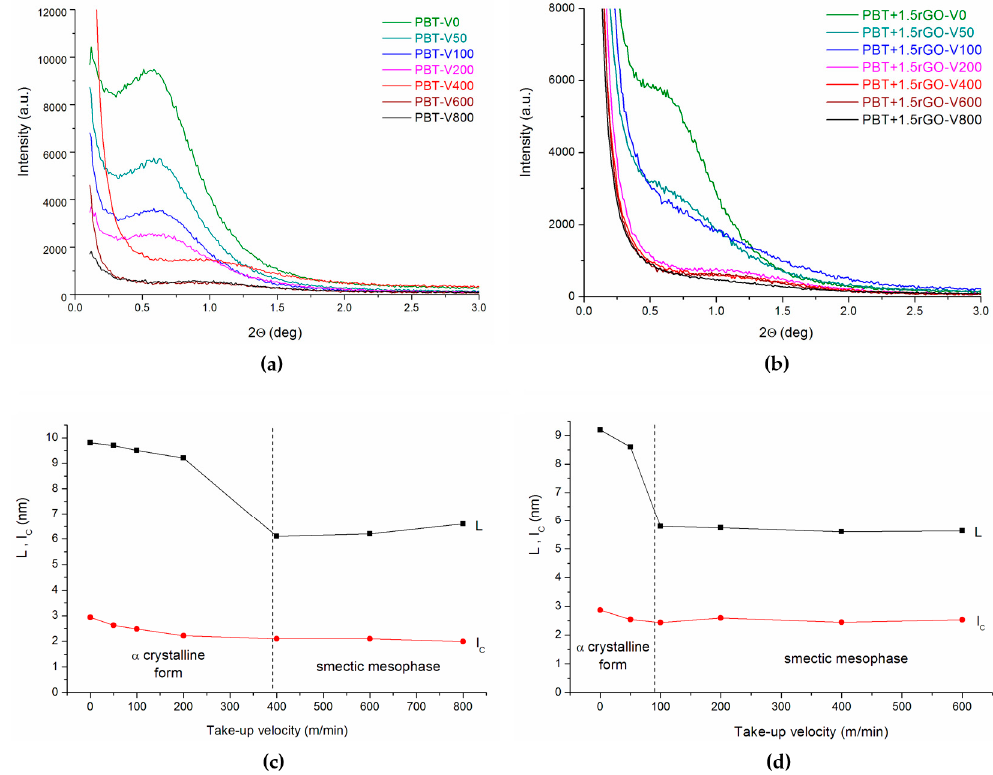
Figure 4. Small-angle X-ray scattering (SAXS) patterns of fibers spun at different take-up velocities: ( a ) PBT; ( b ) PBT + 1.5rGO. Variations in the long period (L) and lamellar crystal thickness (l C ) for fibers: